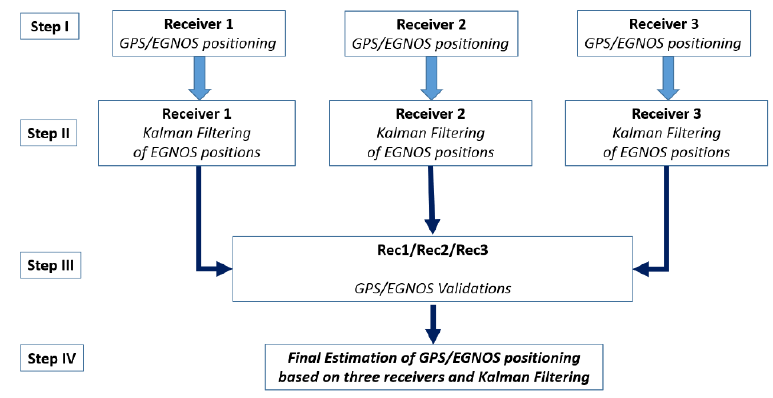
Figure 1. Flow chart of EGNOS positioning by means of three GPS/EGNOS receivers.